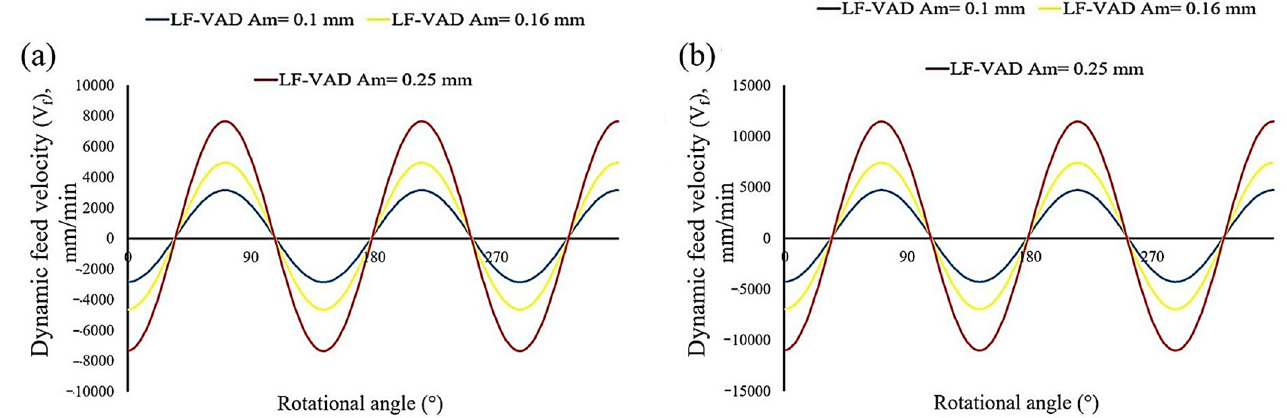
Figure 3. Effect of vibration amplitude (A m ) on the axial tool velocity at different cutting speeds ( a ) N = 2000 rpm ( b ) N = 3000 rpm.